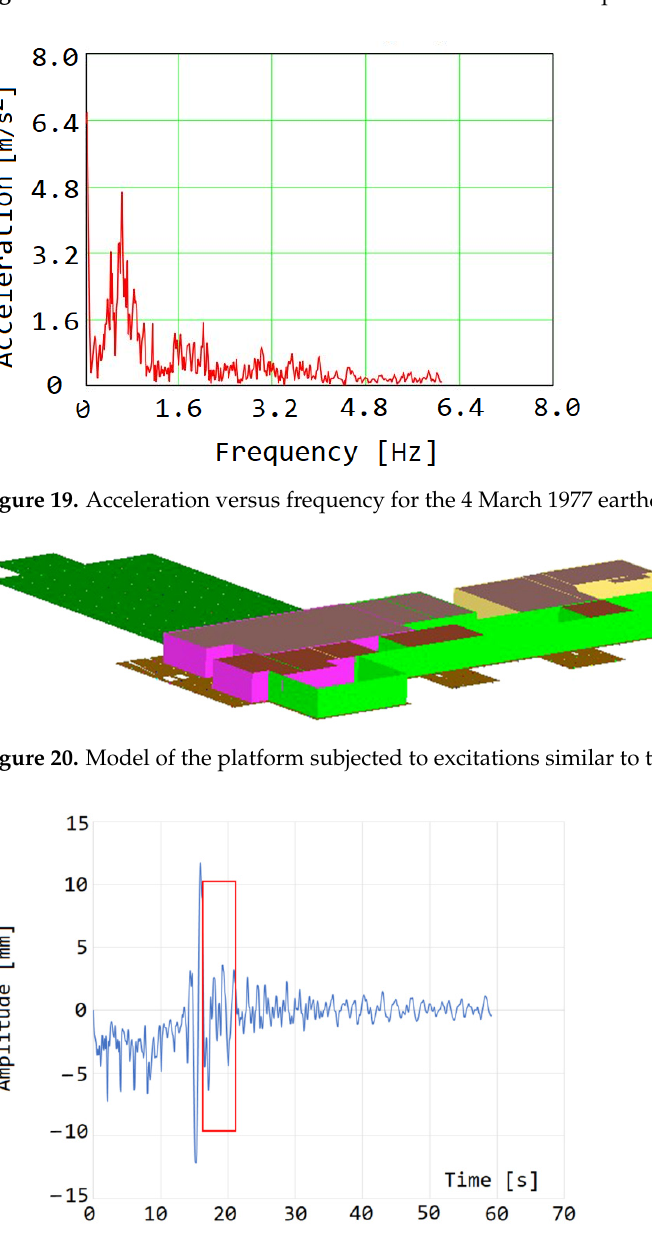
Figure 21. The displacement response of the platform model.